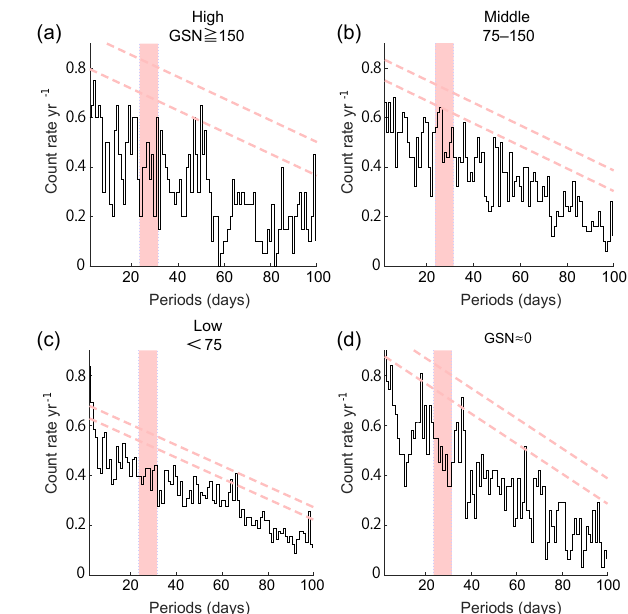
Figure 4. Periodicity of the thunder/lightning events from May to September in Hirosaki for the periods when the GSNs were (a) greater than or equal to 150, (b) from 75 to 150, and (c) less than 75. Also shown is the histogram for (d) the period of AD 1665–1699. The red dashed lines denote 2.0 and 3.0 SDs. The red shaded bars indicate the 24–31 day